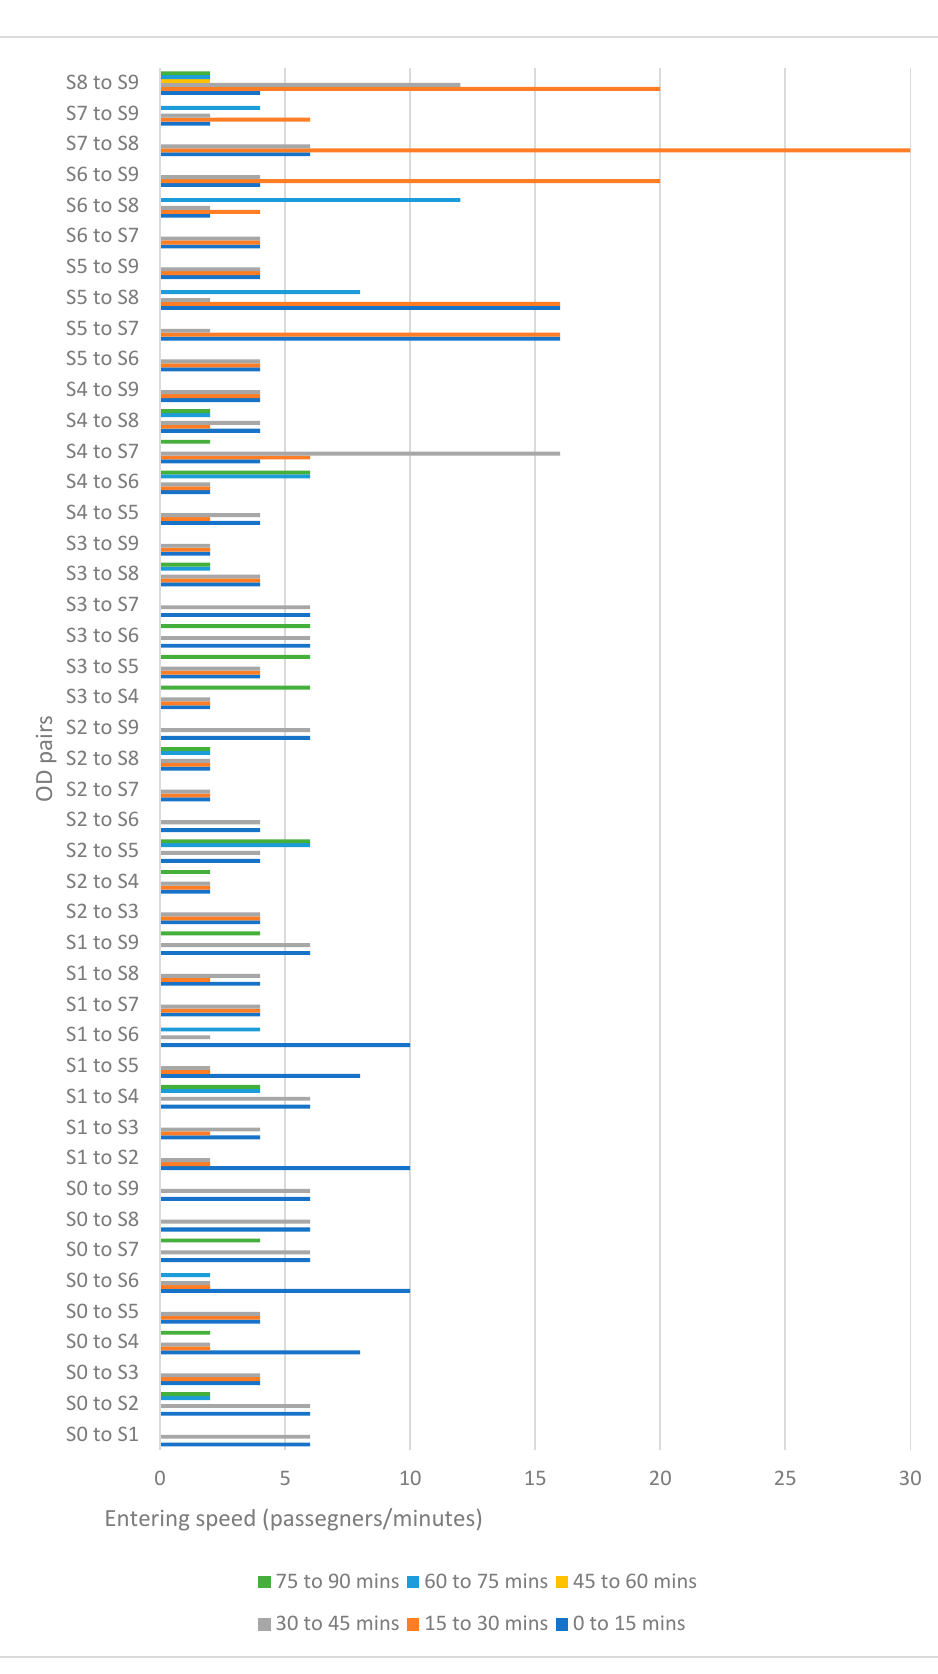
Figure 7. Passenger entering speed OD data.